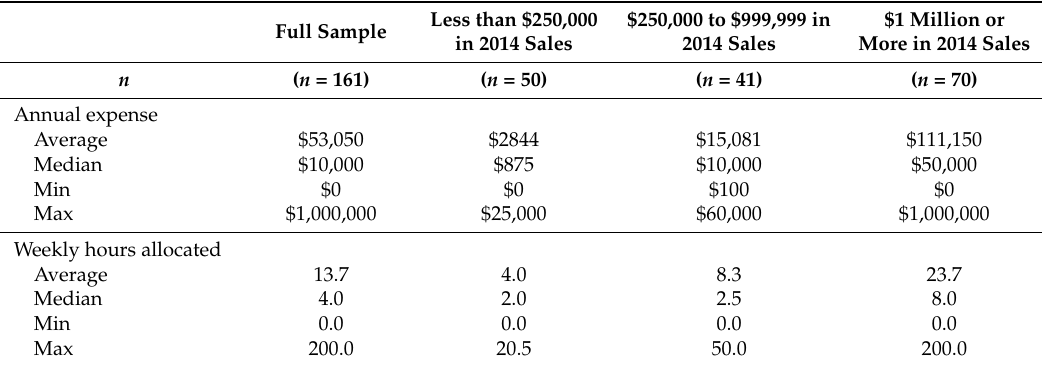
as reported by respondents in the study questionnaire.